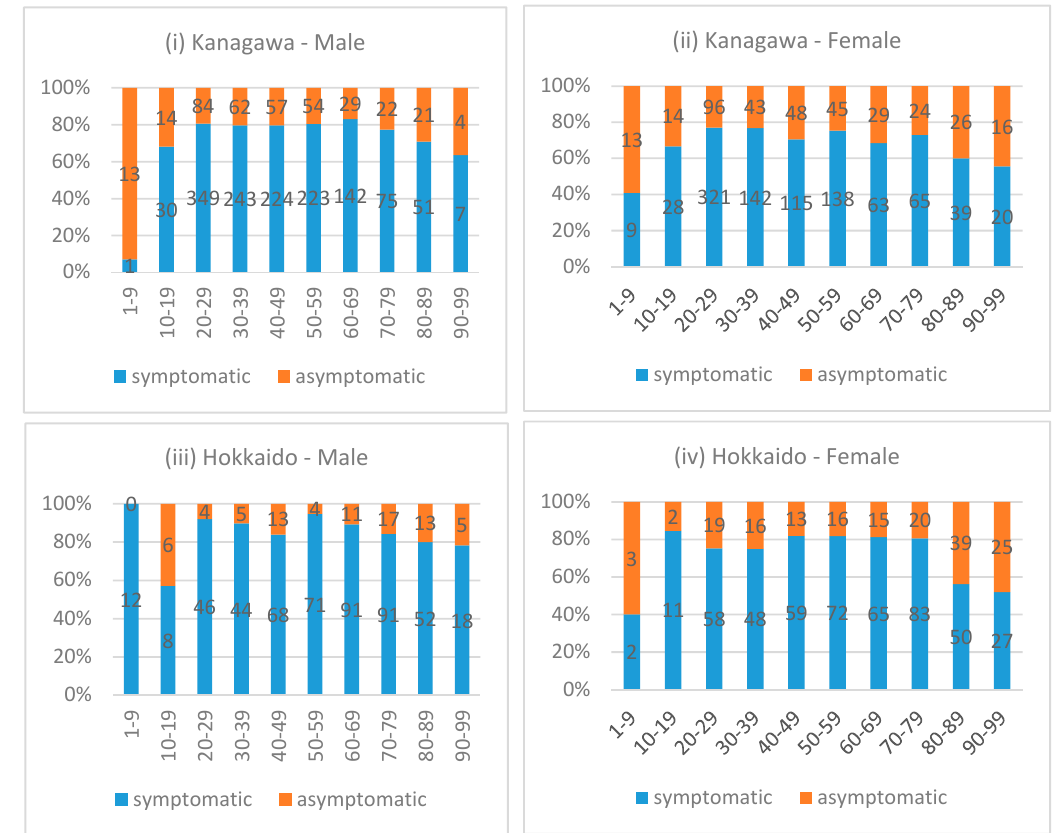
Figure 2. Proportion and the Number of Symptomatic and Asymptomatic Patients by Prefecture and Sex. The proportion and number of symptomatic and asymptomatic COVID-19 patients grouped by age and sex are given for each prefecture. The number of patients showing symptoms is in blue, while asymptomatic numbers are in orange. Table 3. Logistic Regression for the Determinants of Asymptomatic Status.